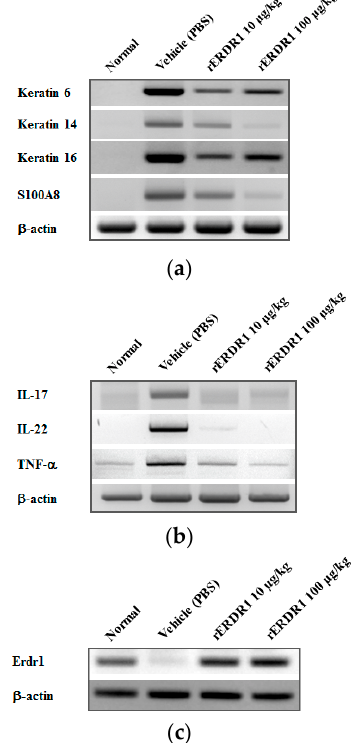
Figure 2. Expression of various biomarkers for psoriasis is regulated by rERDR1 administration.